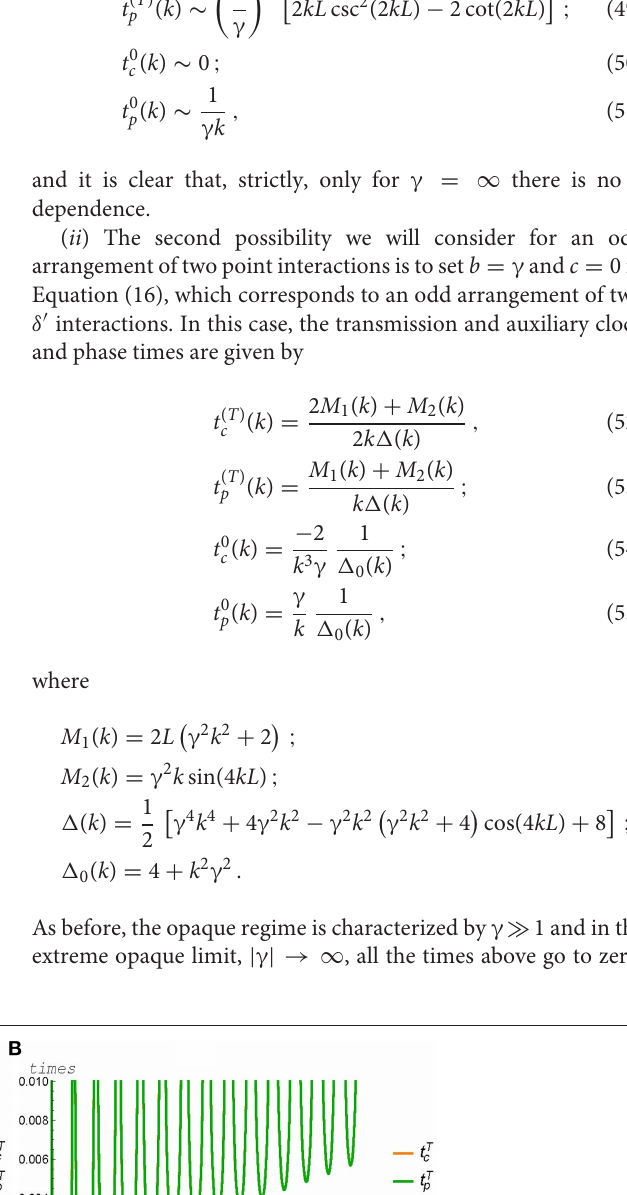
80 and k 1.5 . (B) Double- δ ′ , = =